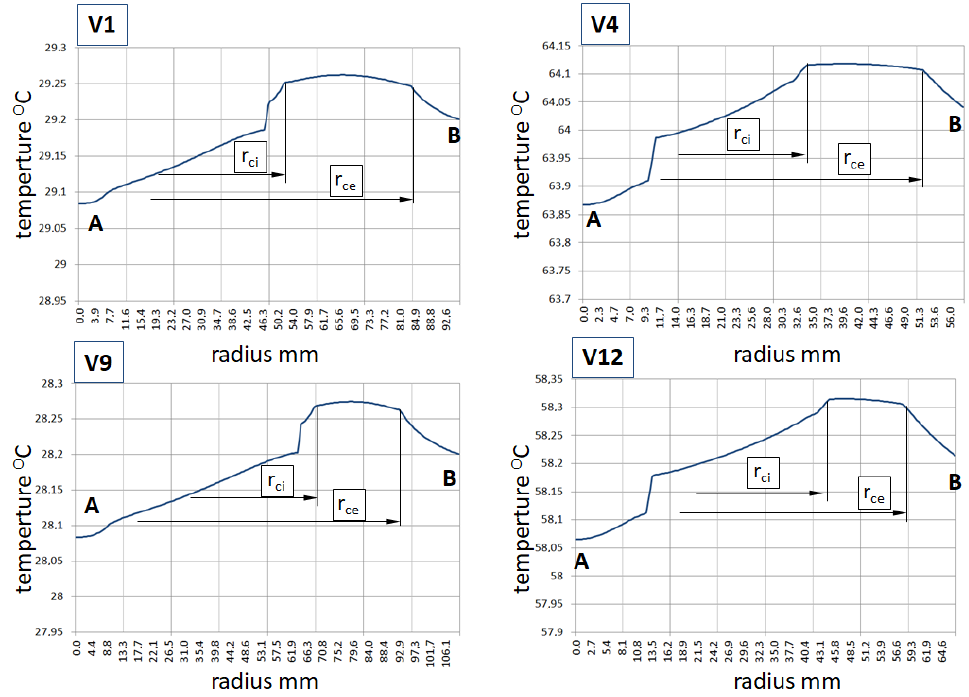
Figure 10. Temperature drop along axis AB in a steady state for selected representative variants: V1 , V4 , V9 and V12